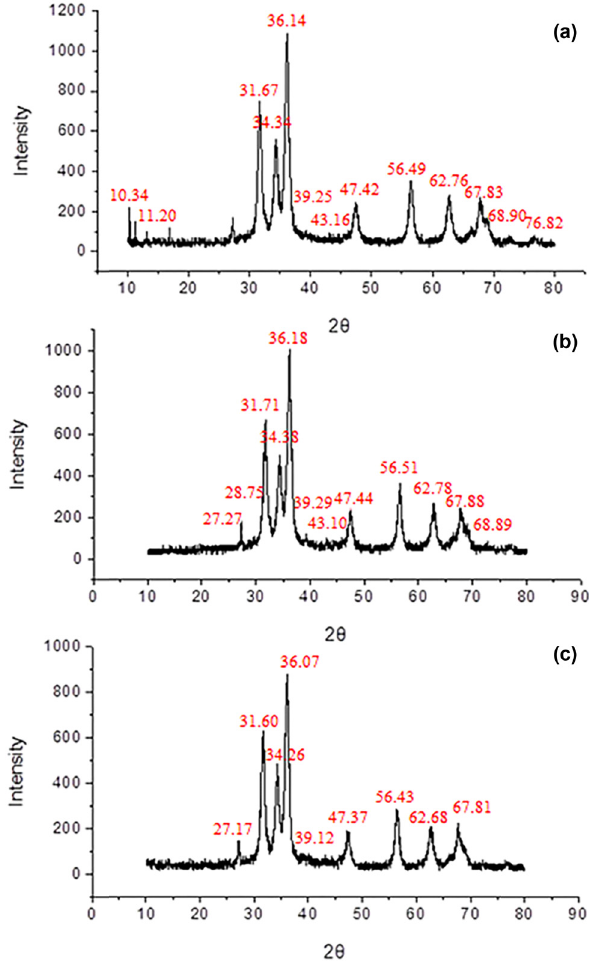
Figure 3: XRD patterns of the fabricated ZnO NPs using red pepper extract through conventional heating ( a ) , autoclave ( b ) , and micro - wave irradiation ( c ) .